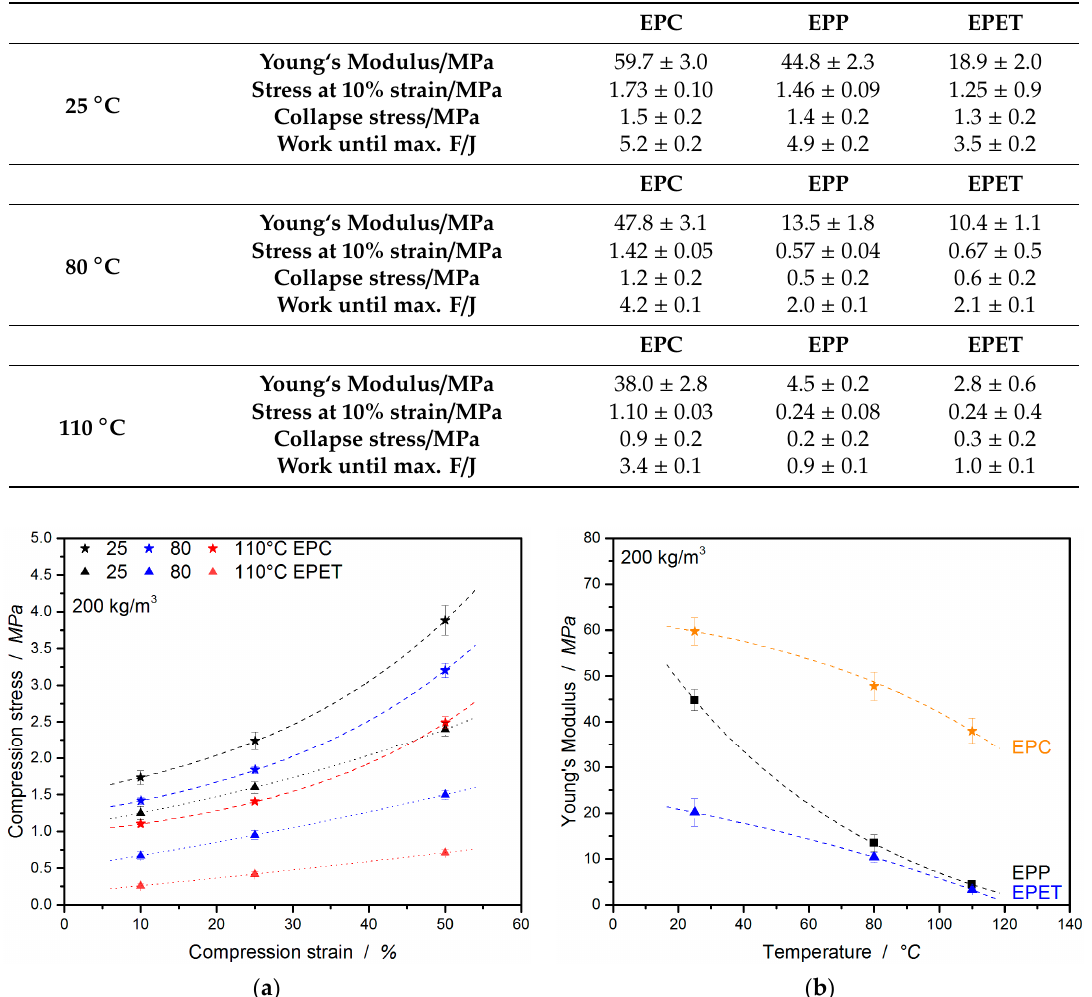
Figure 5. Comparison of compression strength ( a ) and compression moduli ( b ) of EPC and EPP at 25, 80, and 110 °C.